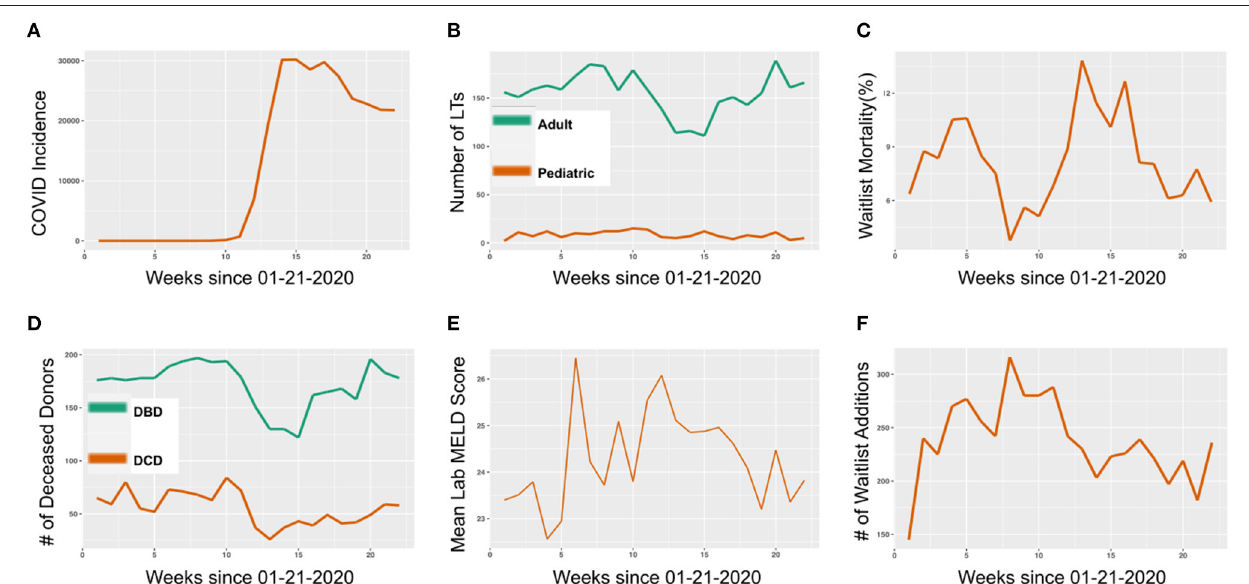
FIGURE 1 | National United States liver transplant (LT) trends in 2020. (A) COVID-19 incidence by week in 2020 (Incidence defined as number of new cases per week). (B) Number of LTs performed by week in 2020, stratified by adult and pediatric LTs. (C) Candidate LT waitlist mortality by week in 2020. (D) Number of deceased organ donors, stratified by donation after brain death (DBD) and donation after circulatory death (DCD) donation, by week in 2020. (E) Mean lab MELD score of LT recipients by week in 2020. (F) Number of new LT waitlist additions by week in